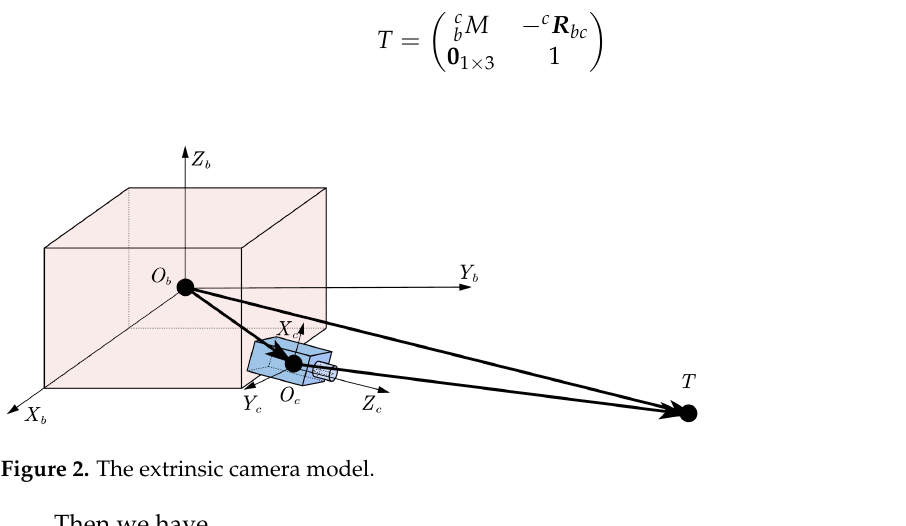
Figure 2. The extrinsic camera